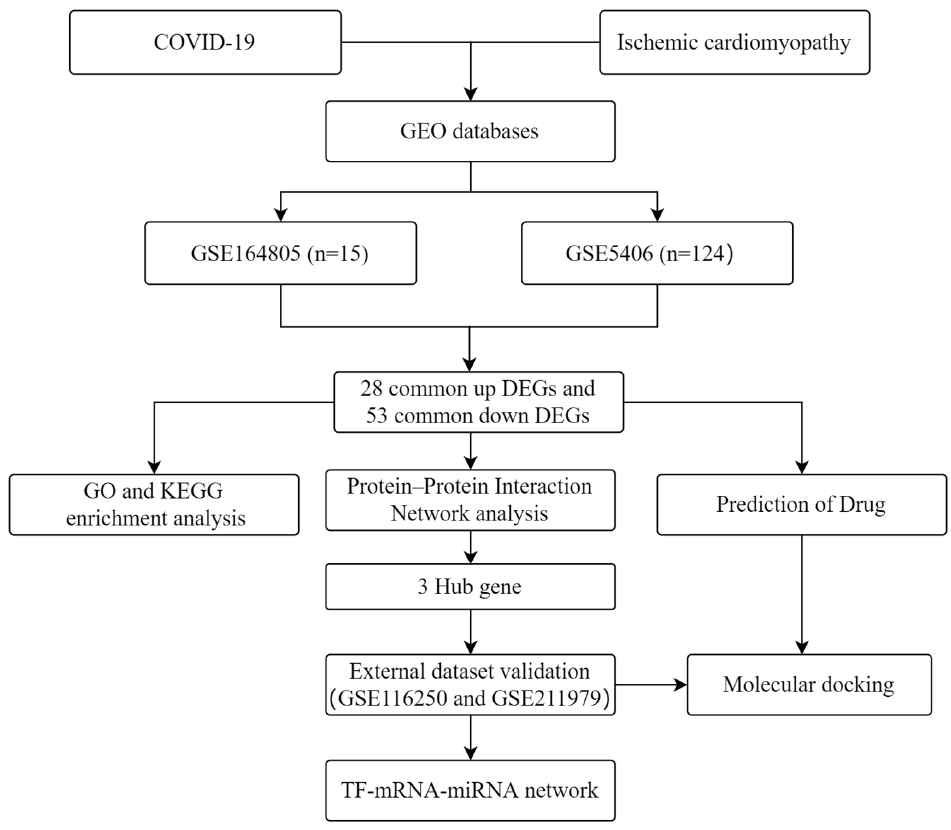
Figure 1. Workflow used in this study to explore potential biomarkers and molecular mechanisms of COVID-19 and ischemic cardiomyopathy by bioinformatics and systems biology methods.